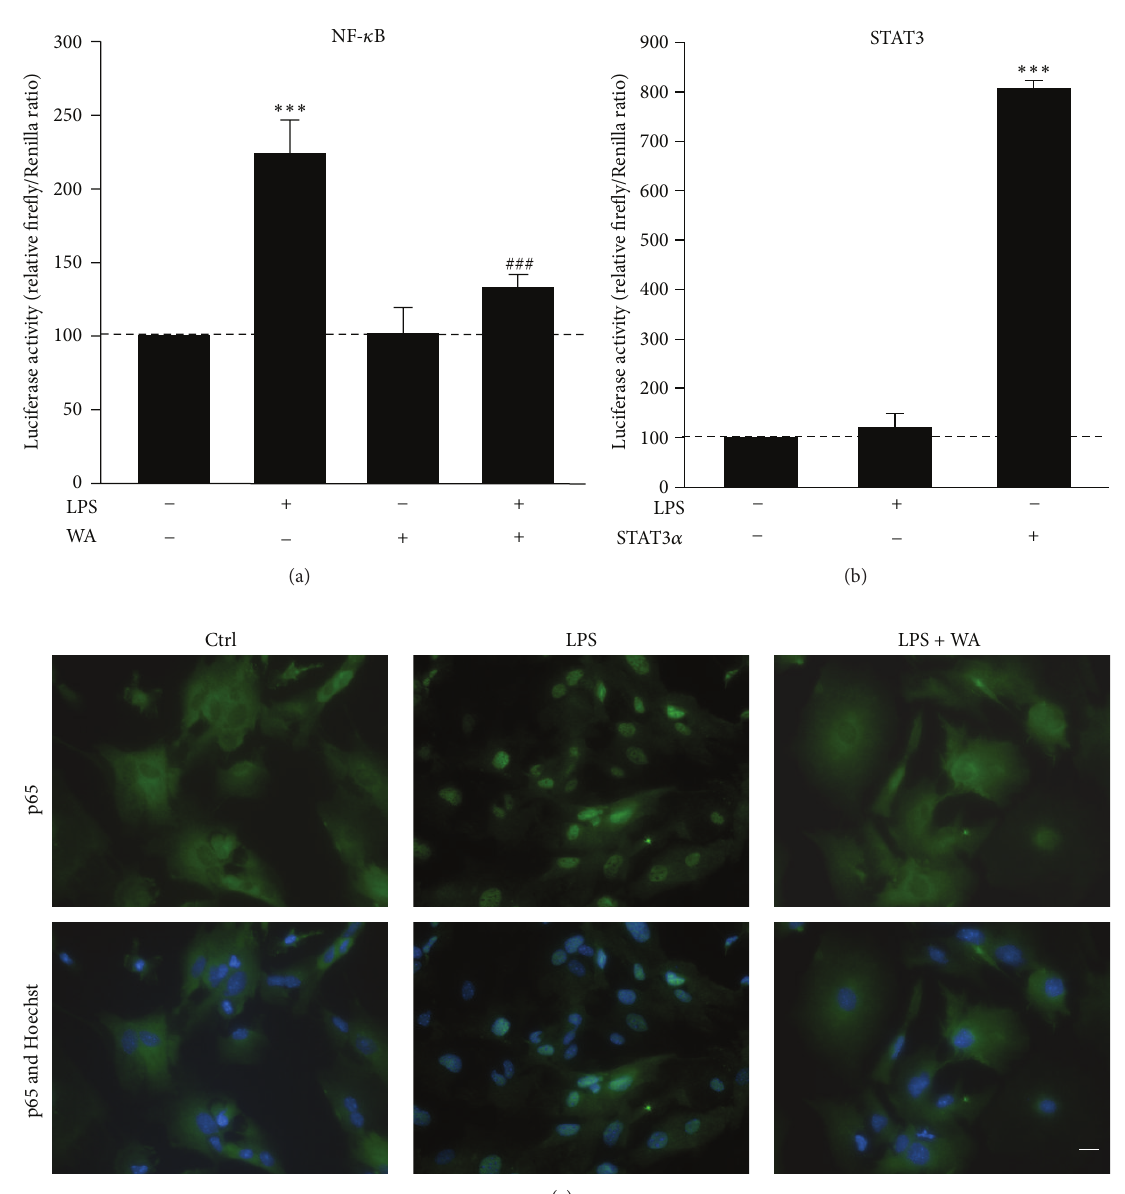
Figure3:EffectsofWithaferinAonLPS-inducedNF- 𝜅